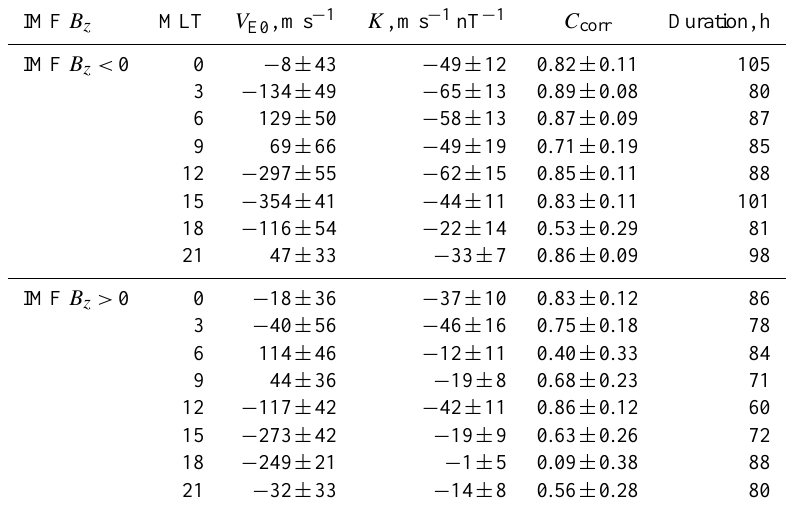
Table 1. The background flow, regression ( K) and correlation ( C corr ) coefficients for the linear approximation of the relationship between V E and IMF B y ; total duration of the observations for each MLT